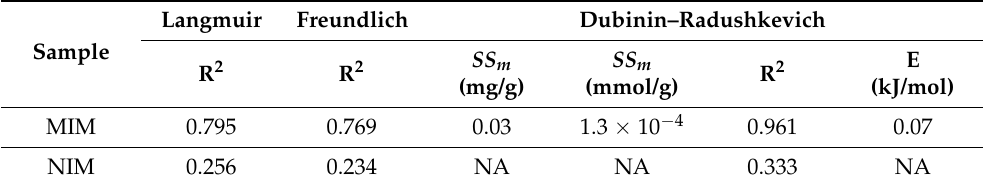
Table 7. Langmuir and Freundlich and Dubinin–Radushkevich fitting parameters MIM and NIM.